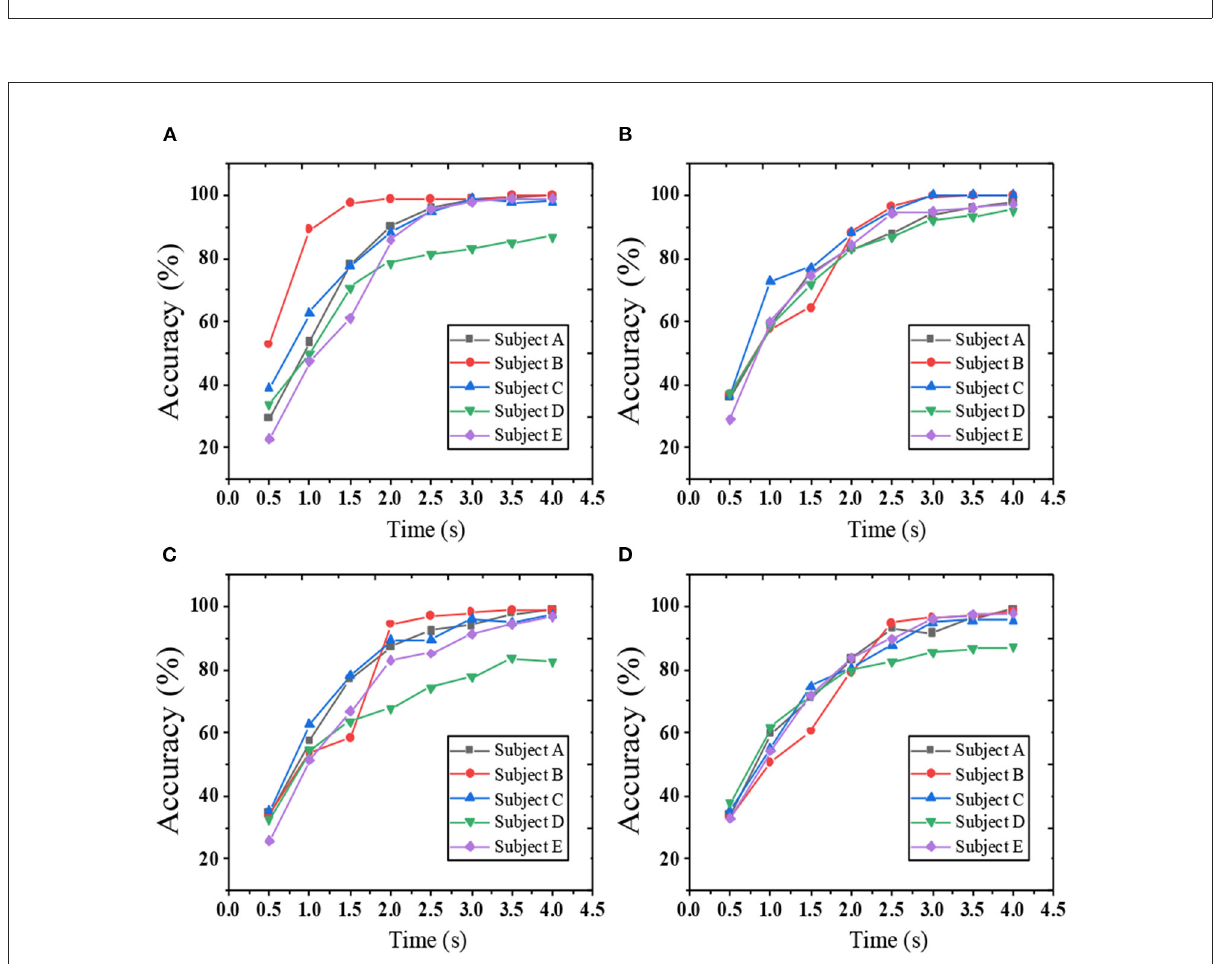
FIGURE5 Correlation coefficients of a single-trial SSVEP of a subject [ (A) position 1; (B) position 2; (C) position 3; (D) position